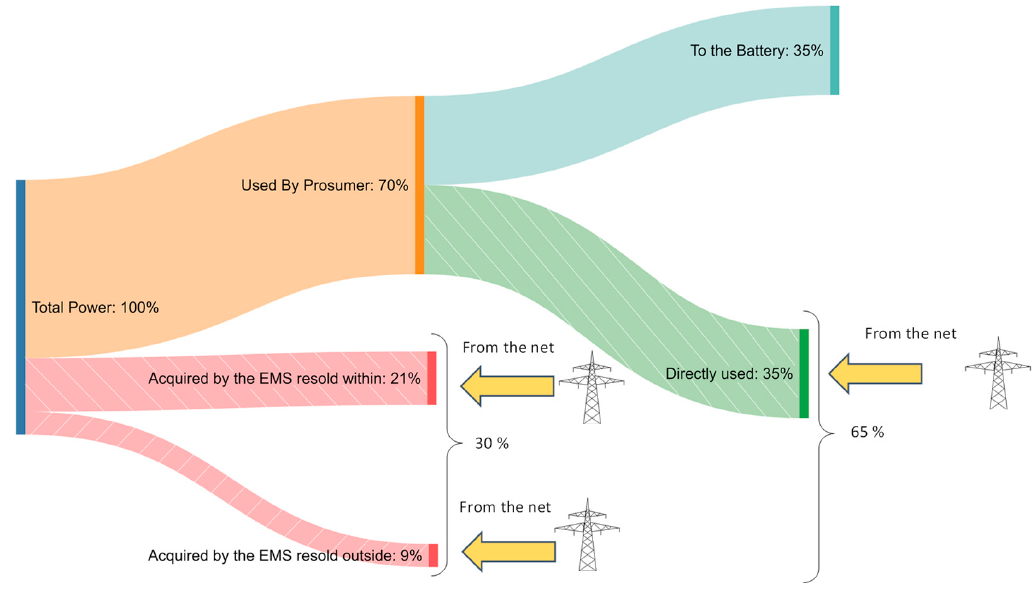
Figure 6. Assumptions for “Downward flexibility”.